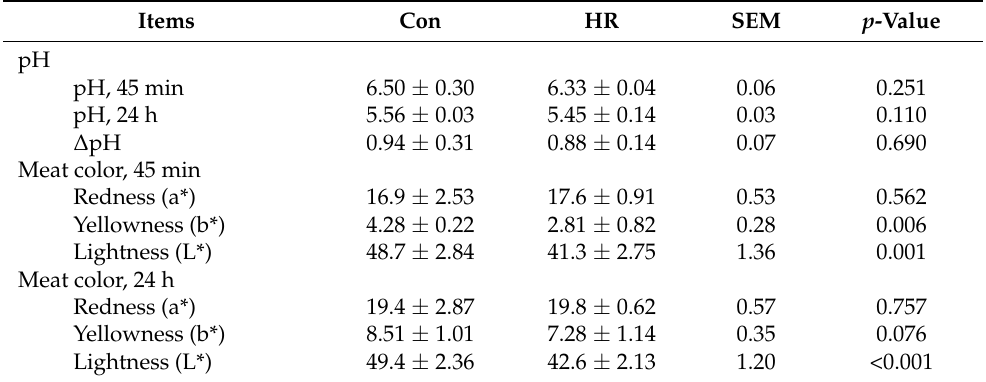
Table 1. The meat quality of growing goats fed the control and high-rice diet a .